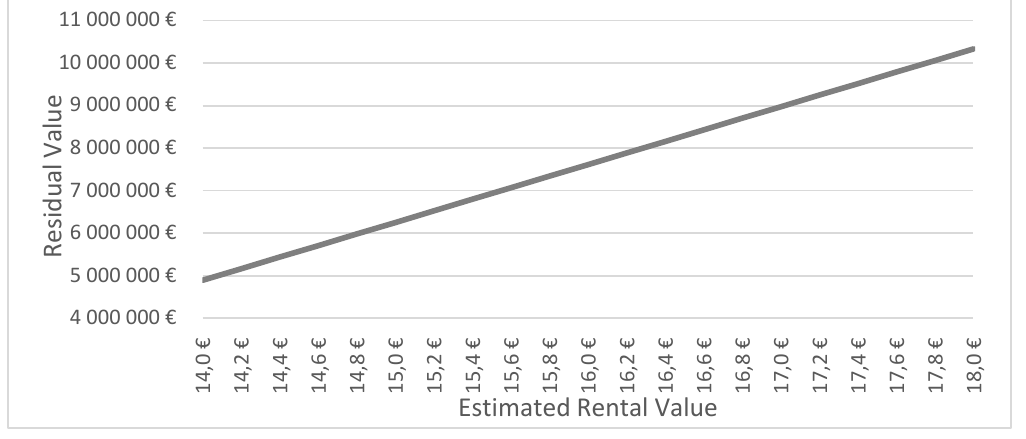
Figure 3: Sensitivity of residual value on ERV (source: